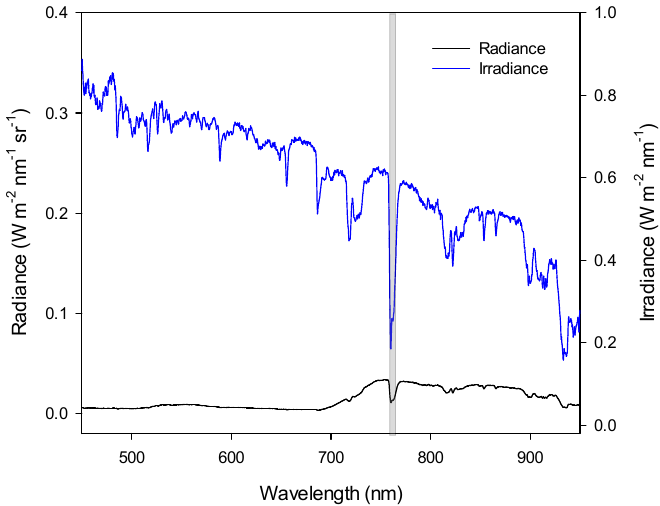
Figure 2. Sample irradiance and radiance spectra measured at 15-min intervals by the Ocean Optics spectrometer system used in this study. Each spectra is the average of 25 consecutive scans. The grey area shows the O 2 -A absorption region around 760 nm used to extract SiF in this study. Note the difference between the ranges of the left and right Y axes, emphasizing the weak reflected signal from the Scots pine canopy.